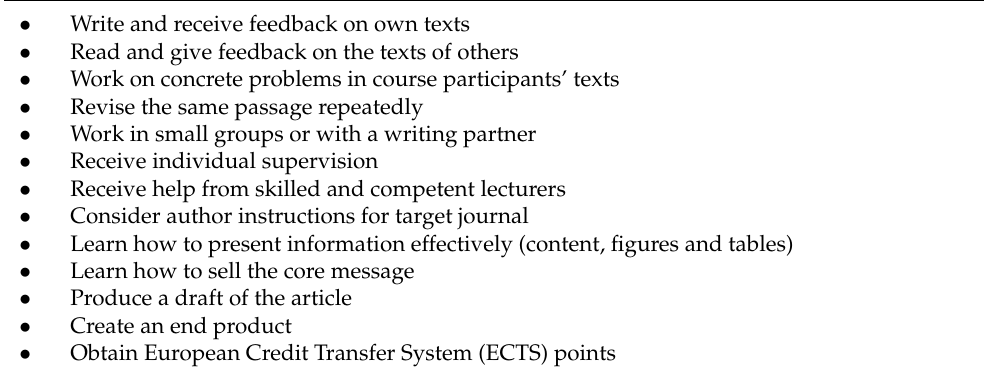
Table 4. Requested course content: Writing the first manuscript for